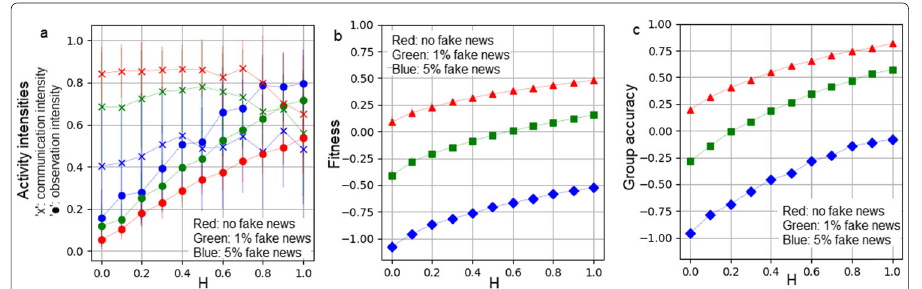
Fig. 2 a The optimal amount of activities: observation (marked with filled ’o’ symbols) and communication (marked with ’x’ symbols), b the fitness values, and c the group accuracy values, as a function of H , for three fake news ratios: 0% (marked with red), 1% (marked with green) and 5%(marked with blue). a The observation activity monotonically increases as a function of H , meaning that members of an optimal group observe proportionally to their abilities. At the same time, at higher H values, the communication activities decrease, at least in case of small fake news ratio. Under exposure to fake news, there is a clear inverse relation between the fake news ratio and the optimal amount of communication. b and c As H increases, the performance of the group also increases, but exposure to fake news deteriorates group-performance severely, for all H values